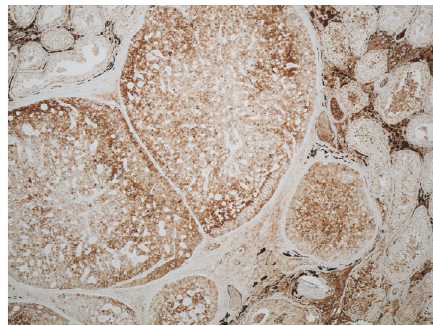
Figure4:Immunohistologicalstainofcalretinin.Allneoplasticcells stain positive for calretinin, 10x